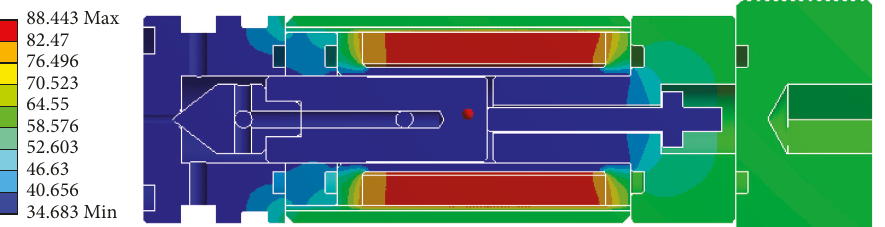
Figure 9: Distribution of temperature field after heat insulation.